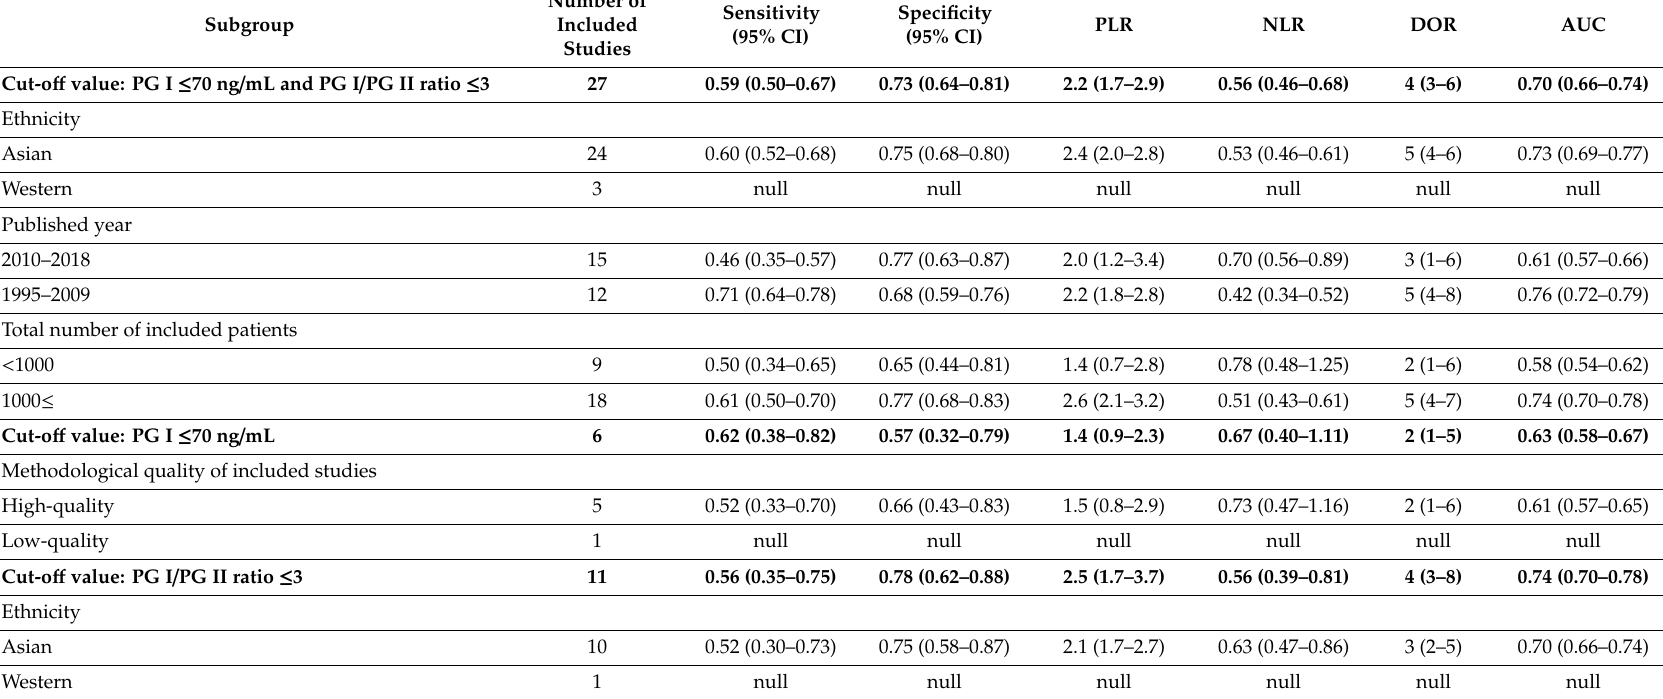
Table 6. Summary of DTA and subgroup analysis of the included studies for the diagnosis of